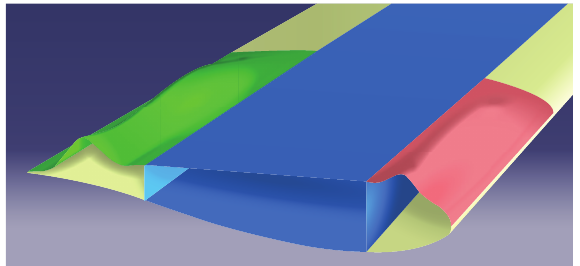
Figure 8: Local perturbation and fixed wing-box parametric repre- sentation in three